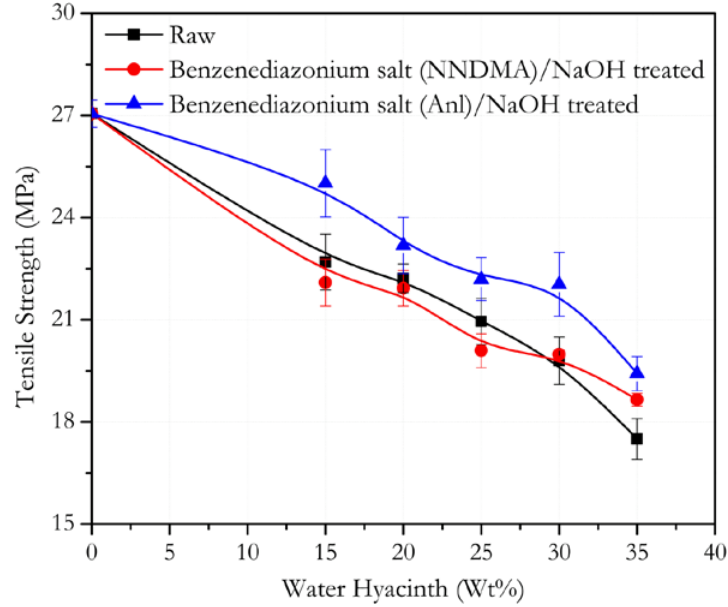
Figure 3: Effect of fiber loading on tensile strength of WH-PP